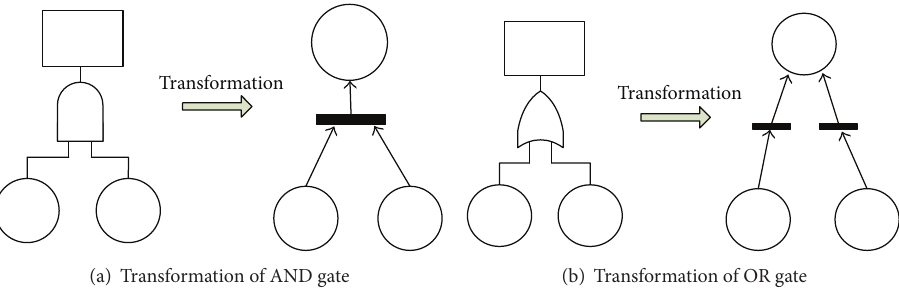
Figure 3: Transformation of AND/OR gate.